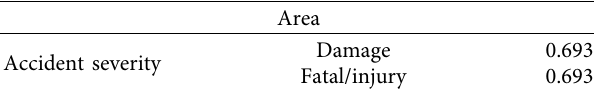
Table 14: The area under the curve for the MLPNN model.